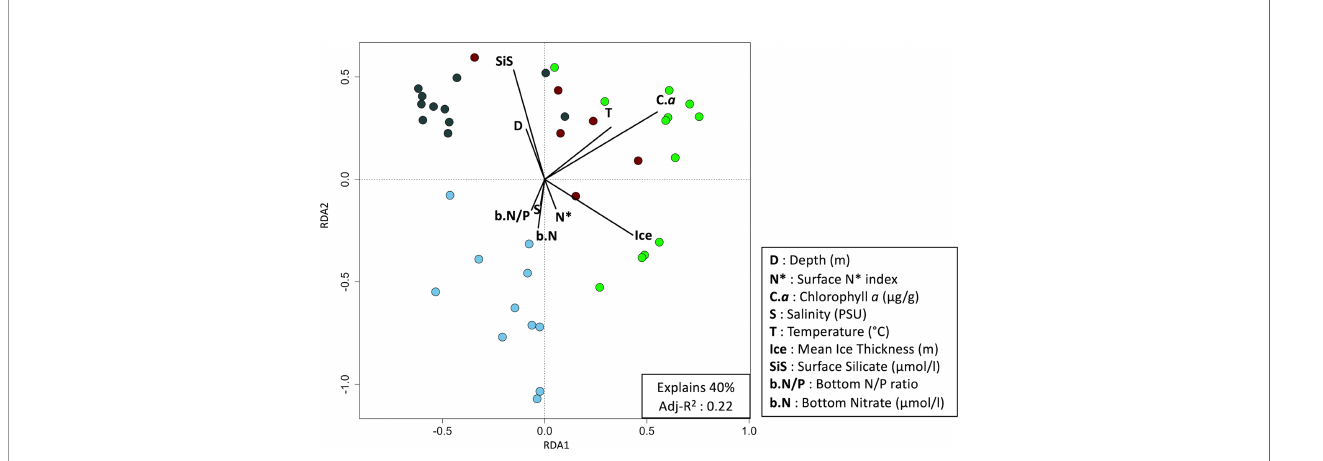
FIGURE 4 | Redundancy analysis plot of the biomass Hellinger transformed 40 infaunal stations sampled between 2010 and 2018 (p-value = 0.0001). Signi fi cant environmental variables were obtained using a two-step forward selection. Colors represent the community determined with a Bray-Curtis distance-based cluster analysis. Green dots are the stations from the fi rst community, pale blues are community 2, dark grays are community 3 and reds are community 4.